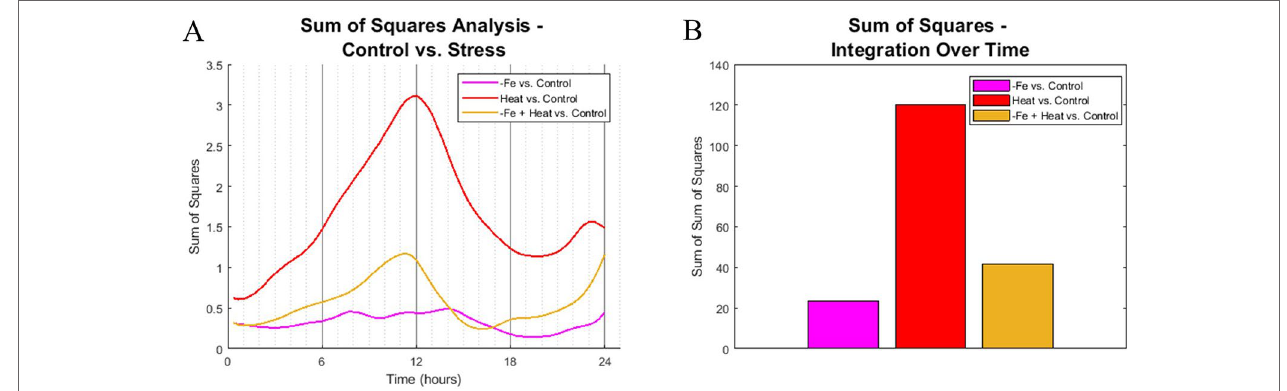
FIgURE 5 | Sum of squares comparison of conditions. (A) Sum of squares analysis was performed every 20 min interval by comparing the high dimensional CYCB1;1:GFP data of stress-inducing experiments to the control. (B) The profiles from (A) were integrated across time to get overall dynamic similarities between